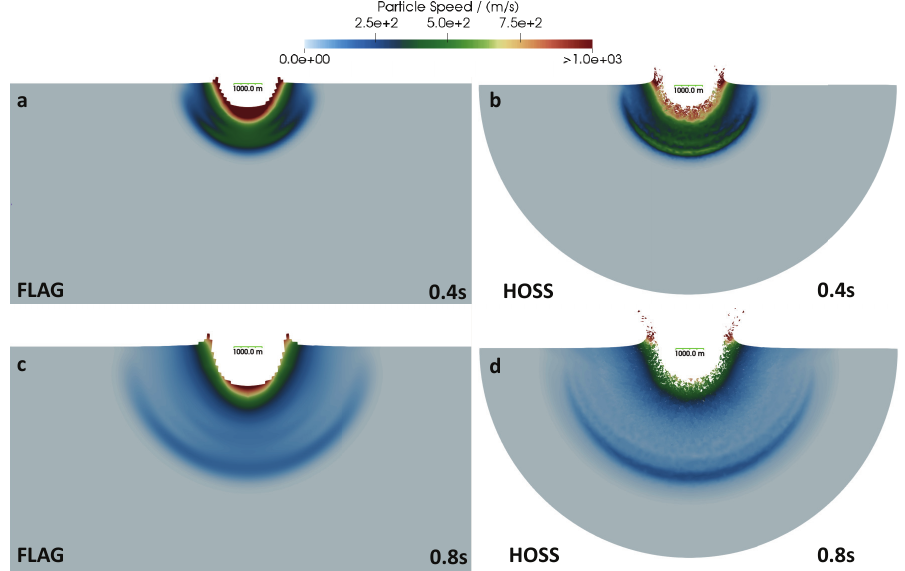
Figure 13. Particle velocity from a 5 × 10 3 m/s normal impact in which strength and damage are considered in the material models. Snapshots are shown at 0.4 s ( a , b ) and 0.8 s ( c , d ) and are calculated from 3D simulations from FLAG and HOSS. ( a , c ) show particle speed from 3D FLAG simulations, and ( b , d ) show particle speed from 3D HOSS simulations. The length of the horizontal green bar shown inside the crater represents a distance of 1000